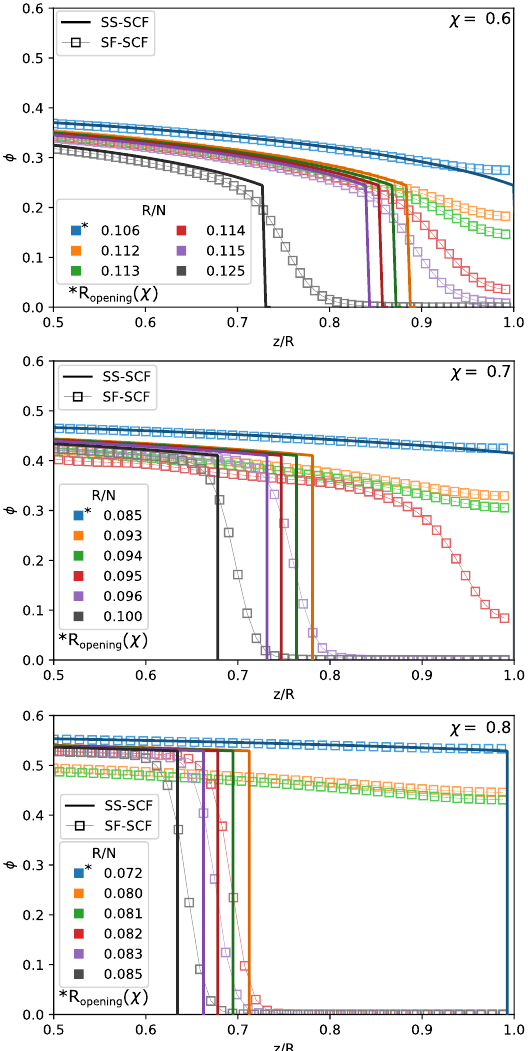
Figure 8. Polymer density profiles φ ( χ , z / R ) as a function of normalised distance from the pore wall z / R for selected values of χ parameter ( 0.6,0.7,0.8 ) corresponding to three frames from the top to bottom for selected values of pore radii, including R opening ( χ ) calculated within SS-SCF approximation and marked by an asterix. Pore radii are color-coded, and the density profiles calculated by numerical SF-SCF method ( φ SF ) are presented as squared markers while solid lines trace the polymer density profiles ( φ SS ) calculated analytically. N = 1000, σ =